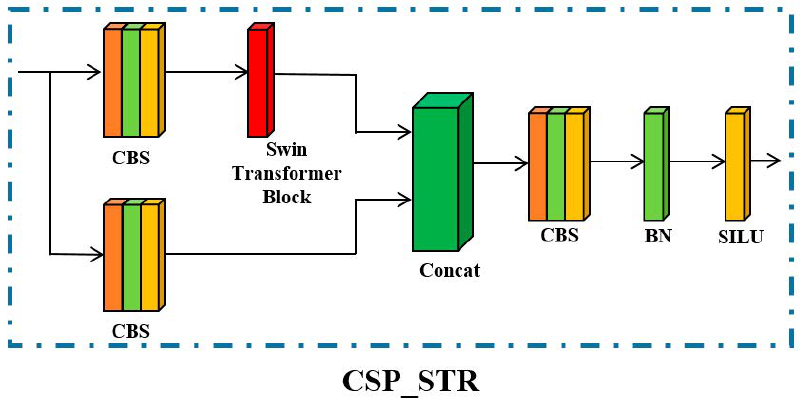
Figure 6. The architecture of the CSP_STR module.